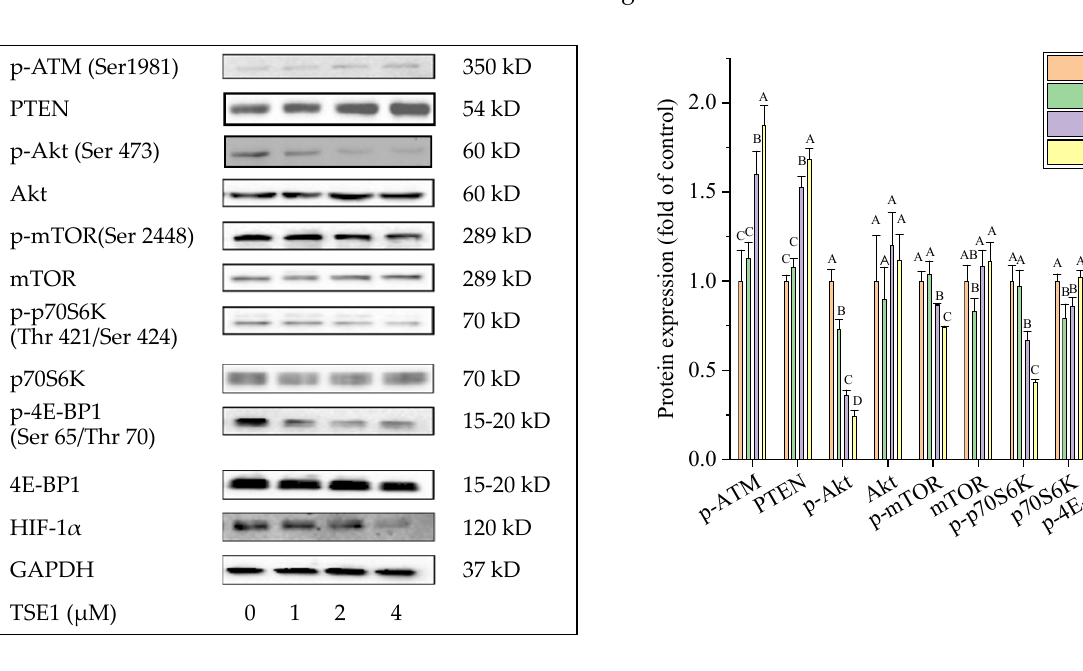
Figure 4. TSE1 inhibited OVCAR-3 cell migration and angiogenesis. ( a ) TSE1 suppressed the migration ability of OVCAR- 3 cells determined by a wound healing assay after 24 h treatment. ( b ) TSE1 inhibited OVCAR-3 cell-induced blood vessel development in the chicken chorioallantoic membrane (CAM) model. ( c ) TSE1 inhibited VEGF secretion in OVCAR-3 cells analyzed by ELISA. ( d ) TSE1 reduced the VEGF protein level in OVCAR-3 cells detected by Western blot. Results were expressed as mean ± SD from three independent experiments. Significant differences among different treatments are marked with different letters ( p < 0.05). * p < 0.05 versus control.